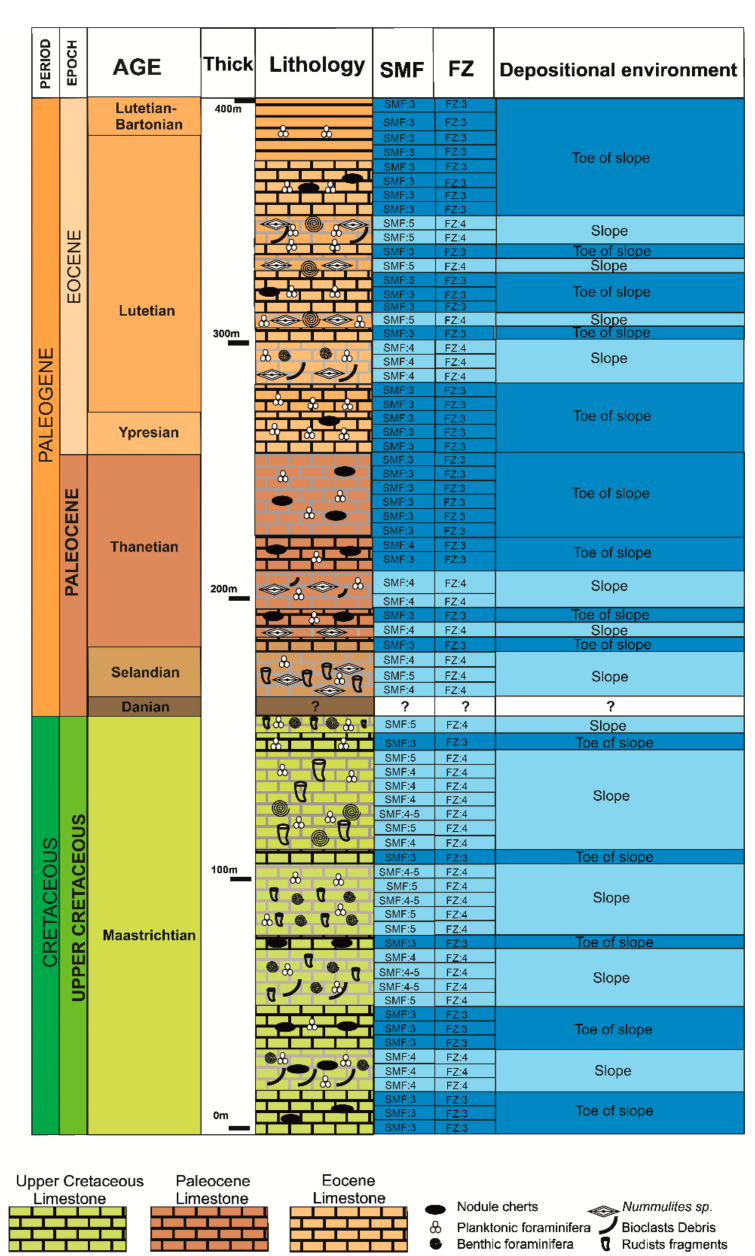
Figure 20. Synthetic lithostratigraphic column of the studied sequence, Microfacies types, and depositional environments of the studied succession at Aetoloakarnania